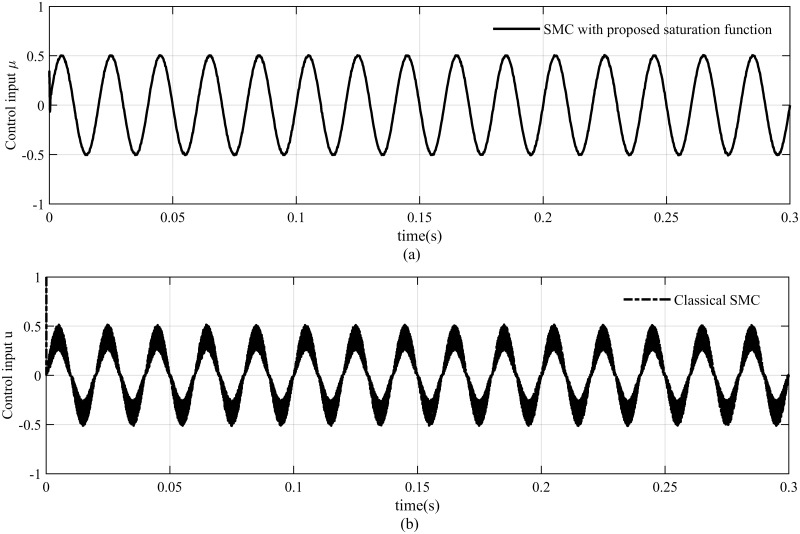
Control input (a) SMC with proposed saturation function (b) classical SMC.